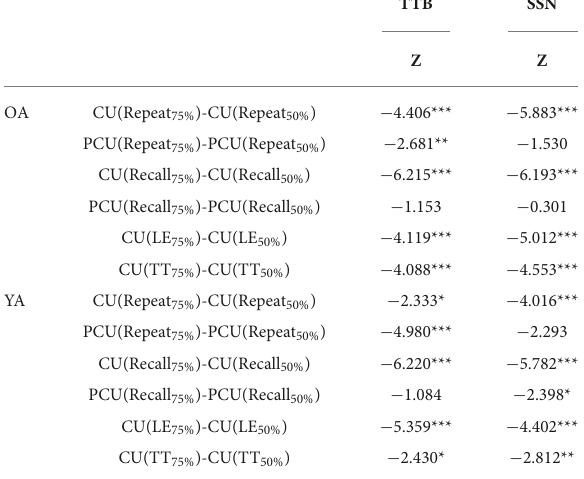
TABLE 3 Differences between SRT75 and SRT50 in two age groups under two noise